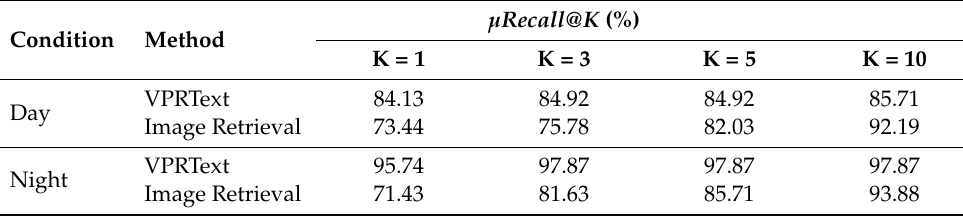
Table 4. Comparison between VPRText vs image retrieval approaches in day/night